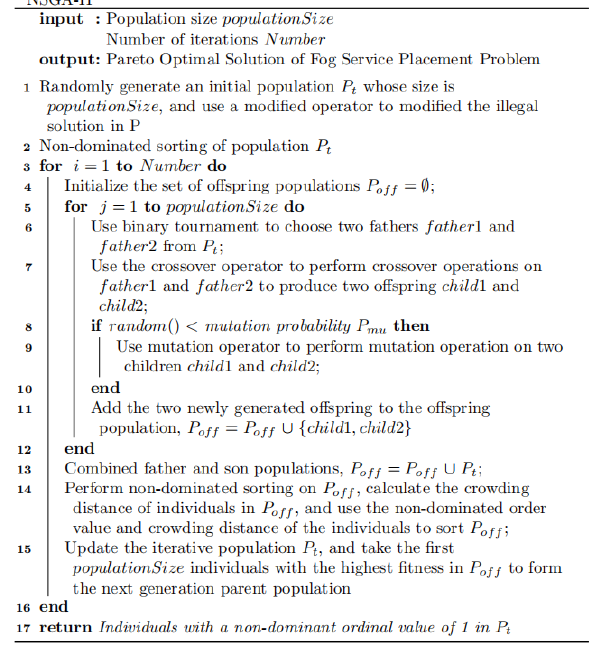
Algorithm 1 calculates the individual crowding